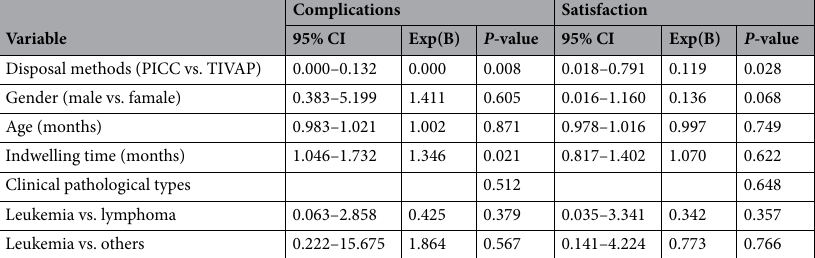
Table 3. Multivariate regression analysis for complications and